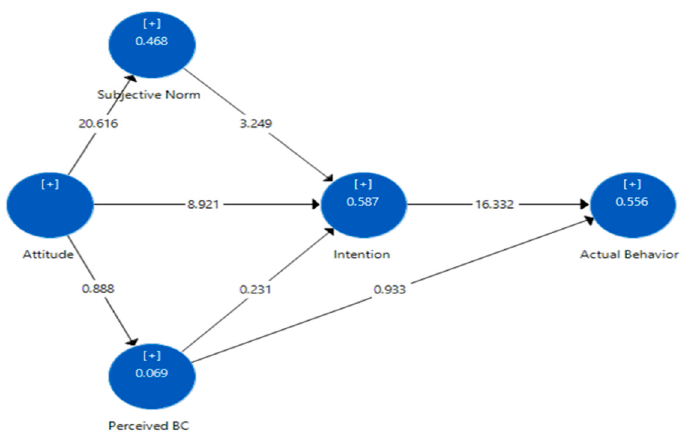
Figure 5. Measurement and structure equation model results of the research model.